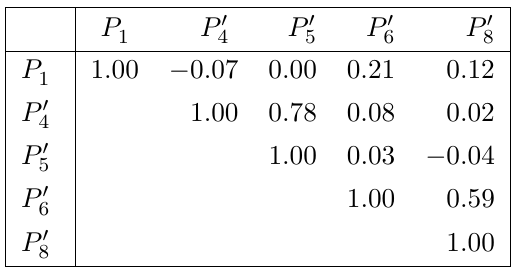
) parameters obtained for q 2 2 [0 : 04 ; 4 : 0] GeV 2 . 0